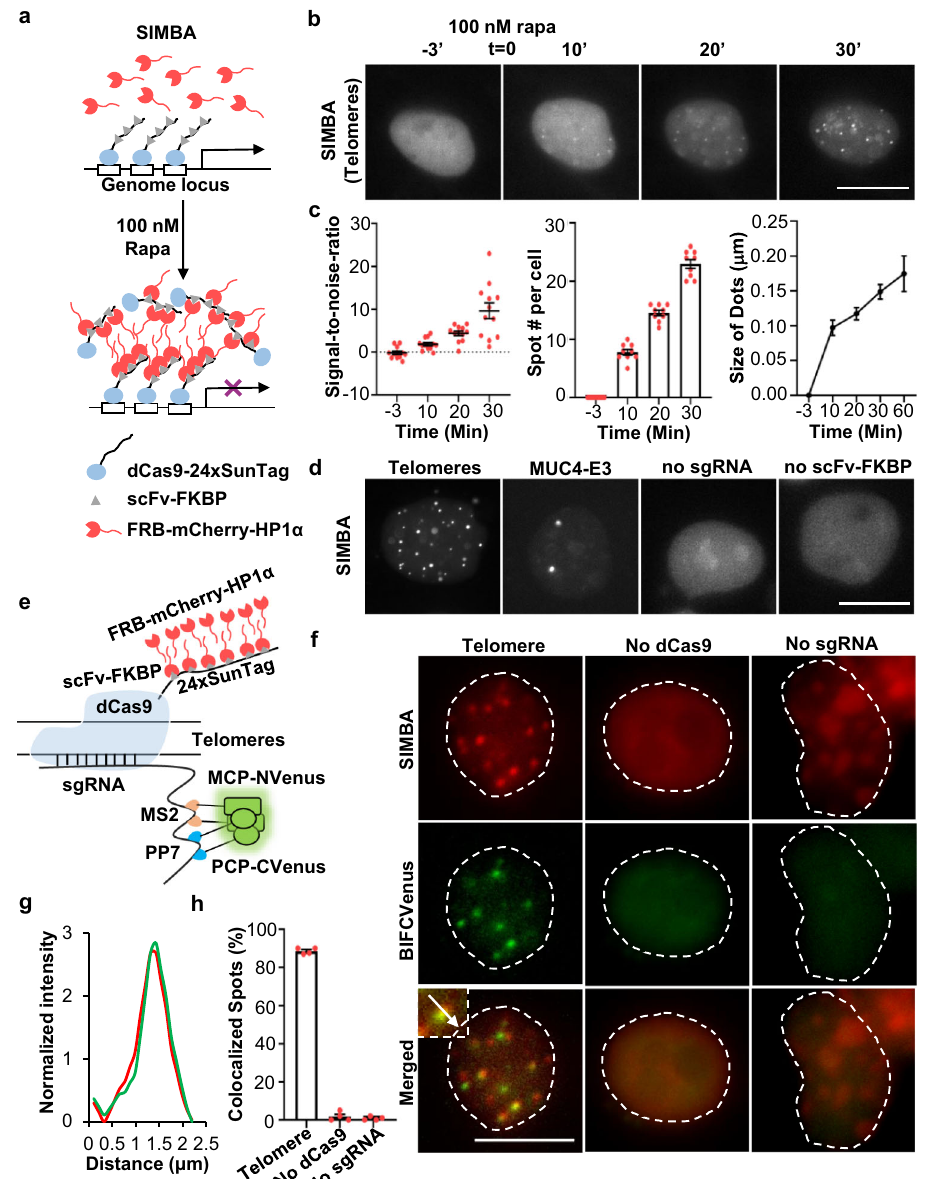
Fig. 1 | The design of SIMBA and its application to label genomic loci with repetitive sequences. a Schematic diagram of SIMBA, with its components including dCas9-24xSunTag, scFv-FKBP, and FRB-mCherry-HP1 α . Upon rapamycin addition, HP1 α can be recruited to target genomic loci and forms puncta. b Representative time-lapse images showing puncta targeted at telomeres formed upon 100nM rapamycin addition. Scale bar, 10 μ m. c Quanti fi ed signal-to-noise ratio(SNR)(Left),thenumbersoflabeledpunctapercelldetectedatdifferenttime points(Middle),and the sizechangeintime uponthe rapamycintreatment (Right) ( n =5,7,8,9,12nuclei).SNRnumberwaslistedinSupplementaryData1.Errorbars, mean±SEM. d Representative images showing puncta formed at the Telomeres or MUC4 locus after 100nM rapamycin treatment for 2 hrs in HEK293T cells. No